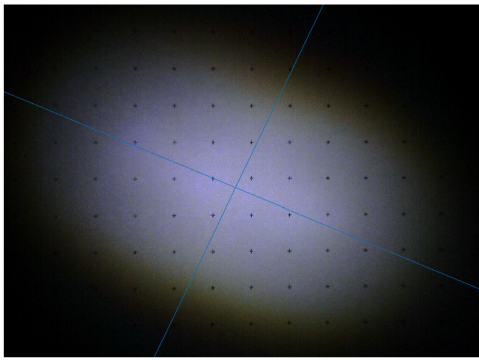
Figure 11. Target spot of the transmission LARP setup at a distance of 1320 mm from the light